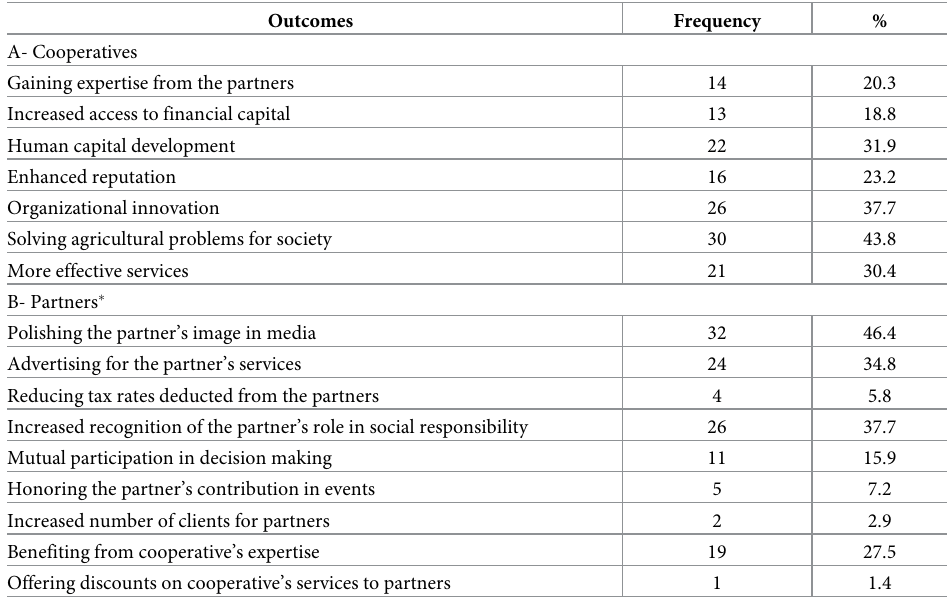
Table 10. Outcomes for both cooperatives and